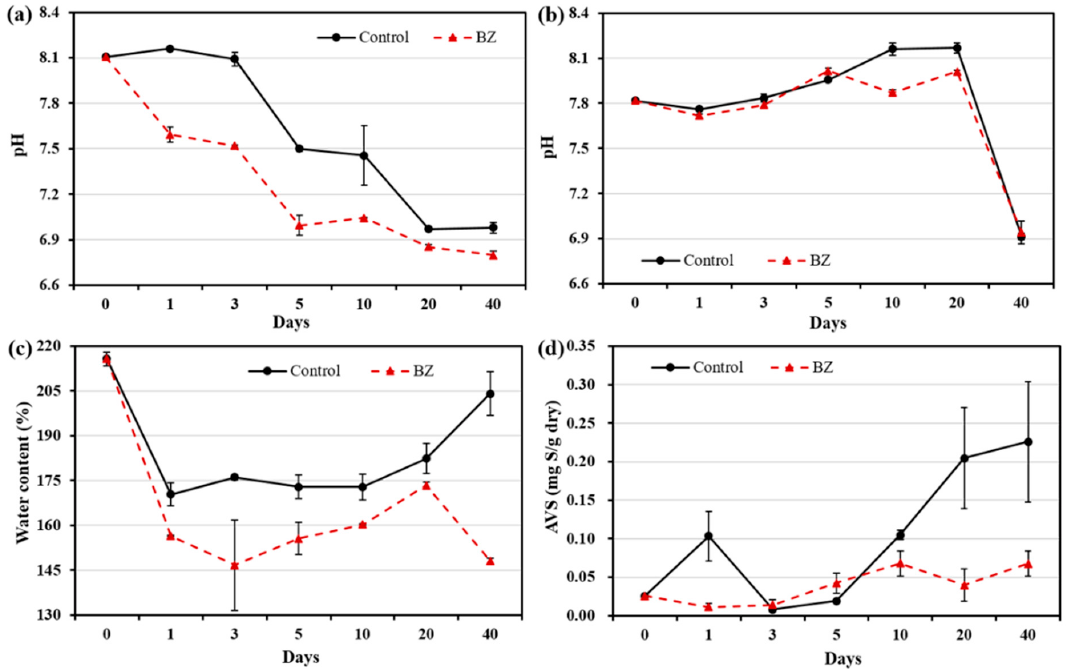
Figure 1. Changes in pH at different times in ( a ) overlying water, ( b ) pore water, and temporal changes in ( c ) water contents and ( d ) AVS. All analytical measurements were performed in triplicate and error bars indicate the standard deviation of the